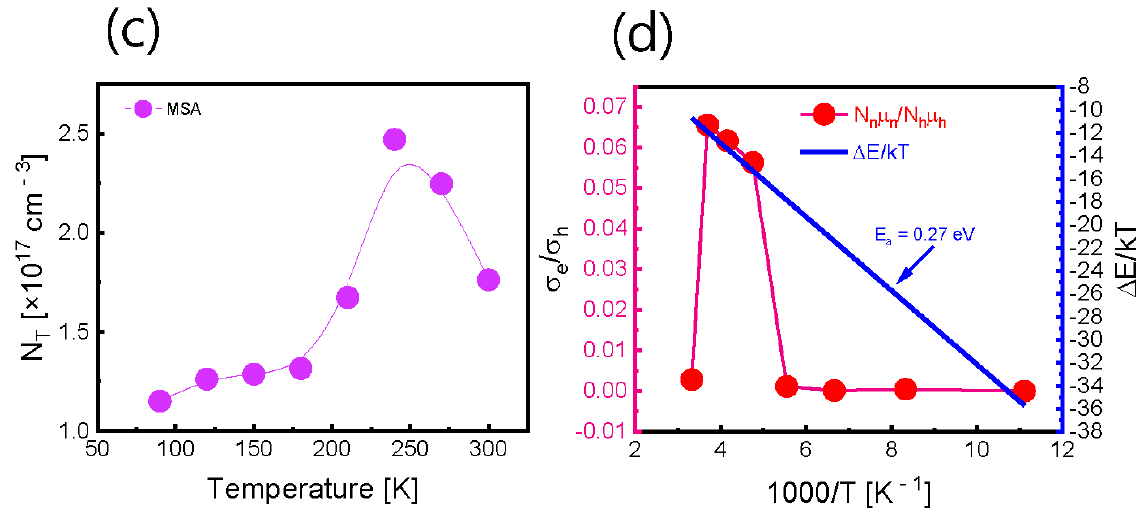
Figure 2. ( a ) Schematic structure of the p -GaAs Schottky diode. ( b ) DLTS signals were obtained using the variation in the t 1 and t 2 when t 2 / t 1 = 2. The inset shows the associated Arrhenius plot. ( c ) Trap densities calculated from the DLTS method using the majority carrier density obtained from the